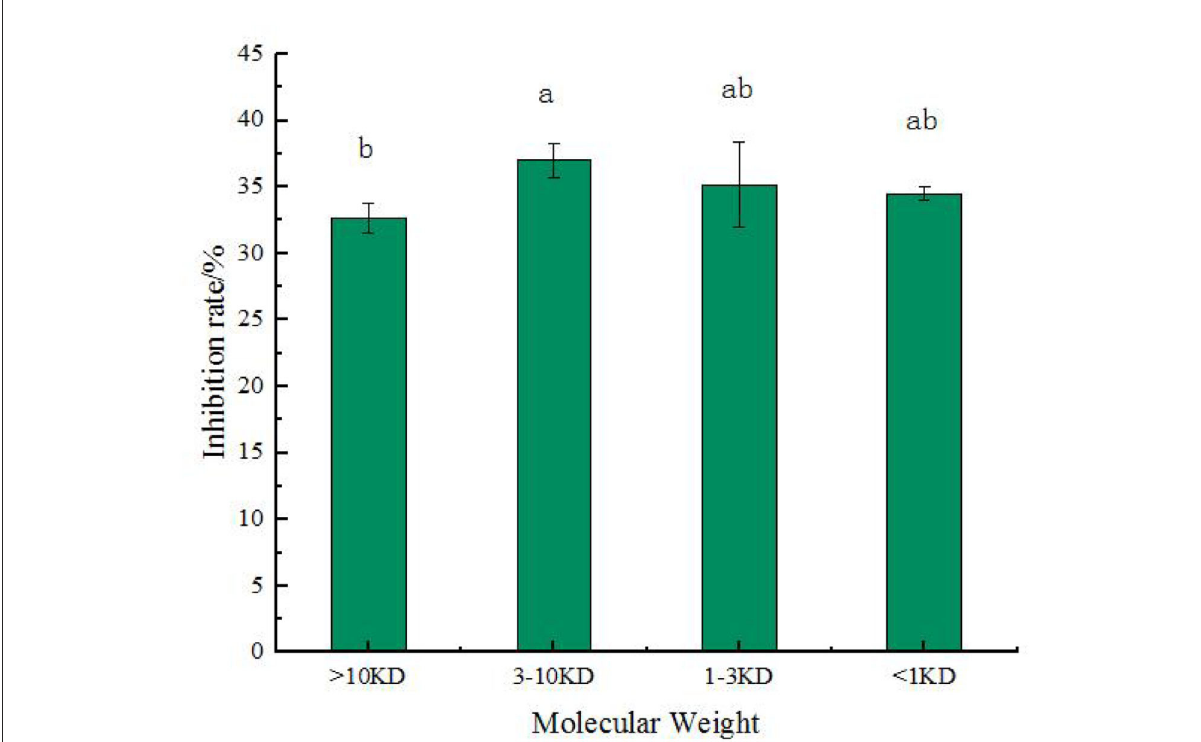
FIGURE6 The rate of α -glucosidase inhibition by four molecular weight in the chickpea peptide fermented by Lactobacillus acidophilus. Values are presented as the mean of three replicates ± standard deviation. Different letters denotes significant differences among samples ( p -value ≤